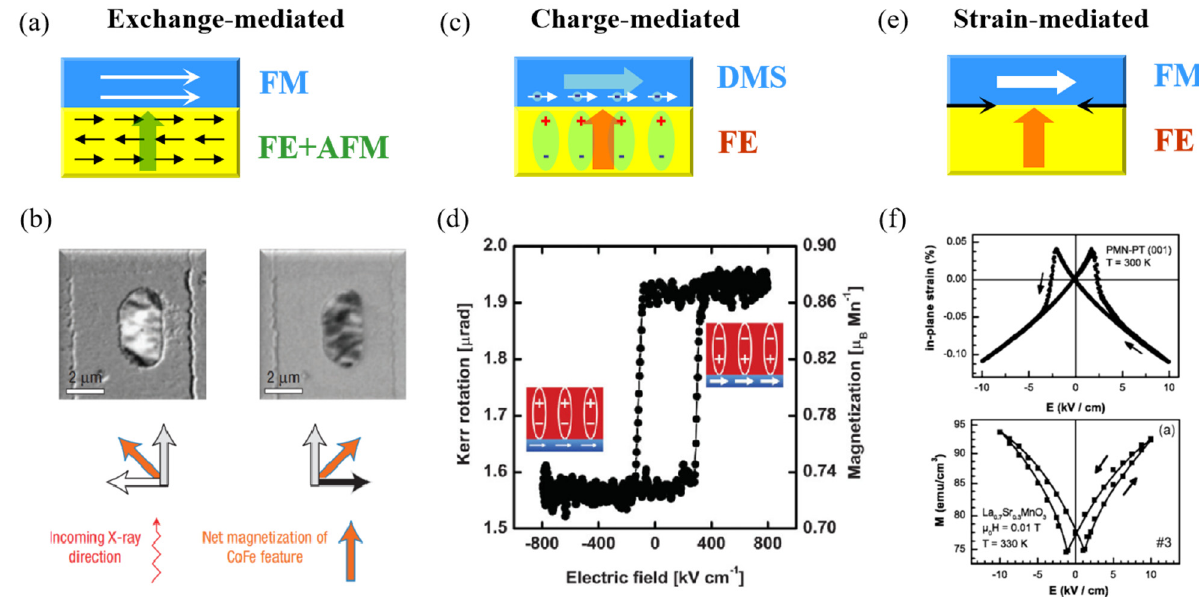
Figure 2. ME coupling through three main mechanisms in the FM/FE multiferroic heterostructure. ( a ) Exchange-mediated. ( b ) The representative work that the net in-plane magnetization of CoFe was controlled by the electric field at room temperature. ( c ) Charge-mediated. ( d ) The representative work that the nonvolatile electric field of Kerr rotation in LSMO/PZT heterostructure at 100 K. ( e ) Strain-mediated. ( f ) The representative work that the in-plane magnetization of La 0.7 Sr 0.3 MnO 3 film was tuned by the strain of the PMN–PT FE substrate. Both of the in-plane strain and magnetization versus electric field curves show the butterfly-like shape. Reproduced with permission from reference [18,23,26].